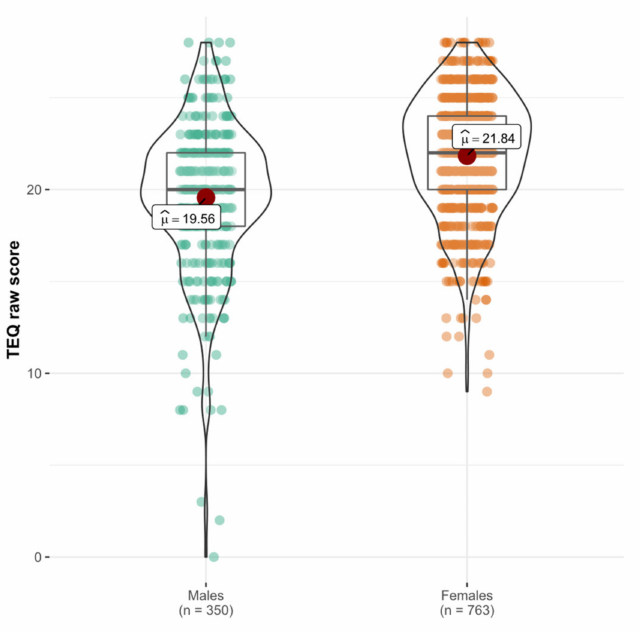
Figure 1. Violin plot with gender differences in empathy (Study 1, n = 1141). The TEQ score distribution across two genders; ˆ µ = means empathy score. TEQ raw score is calculated from the final set of items resulting from the EFA. TEQ = Toronto Empathy